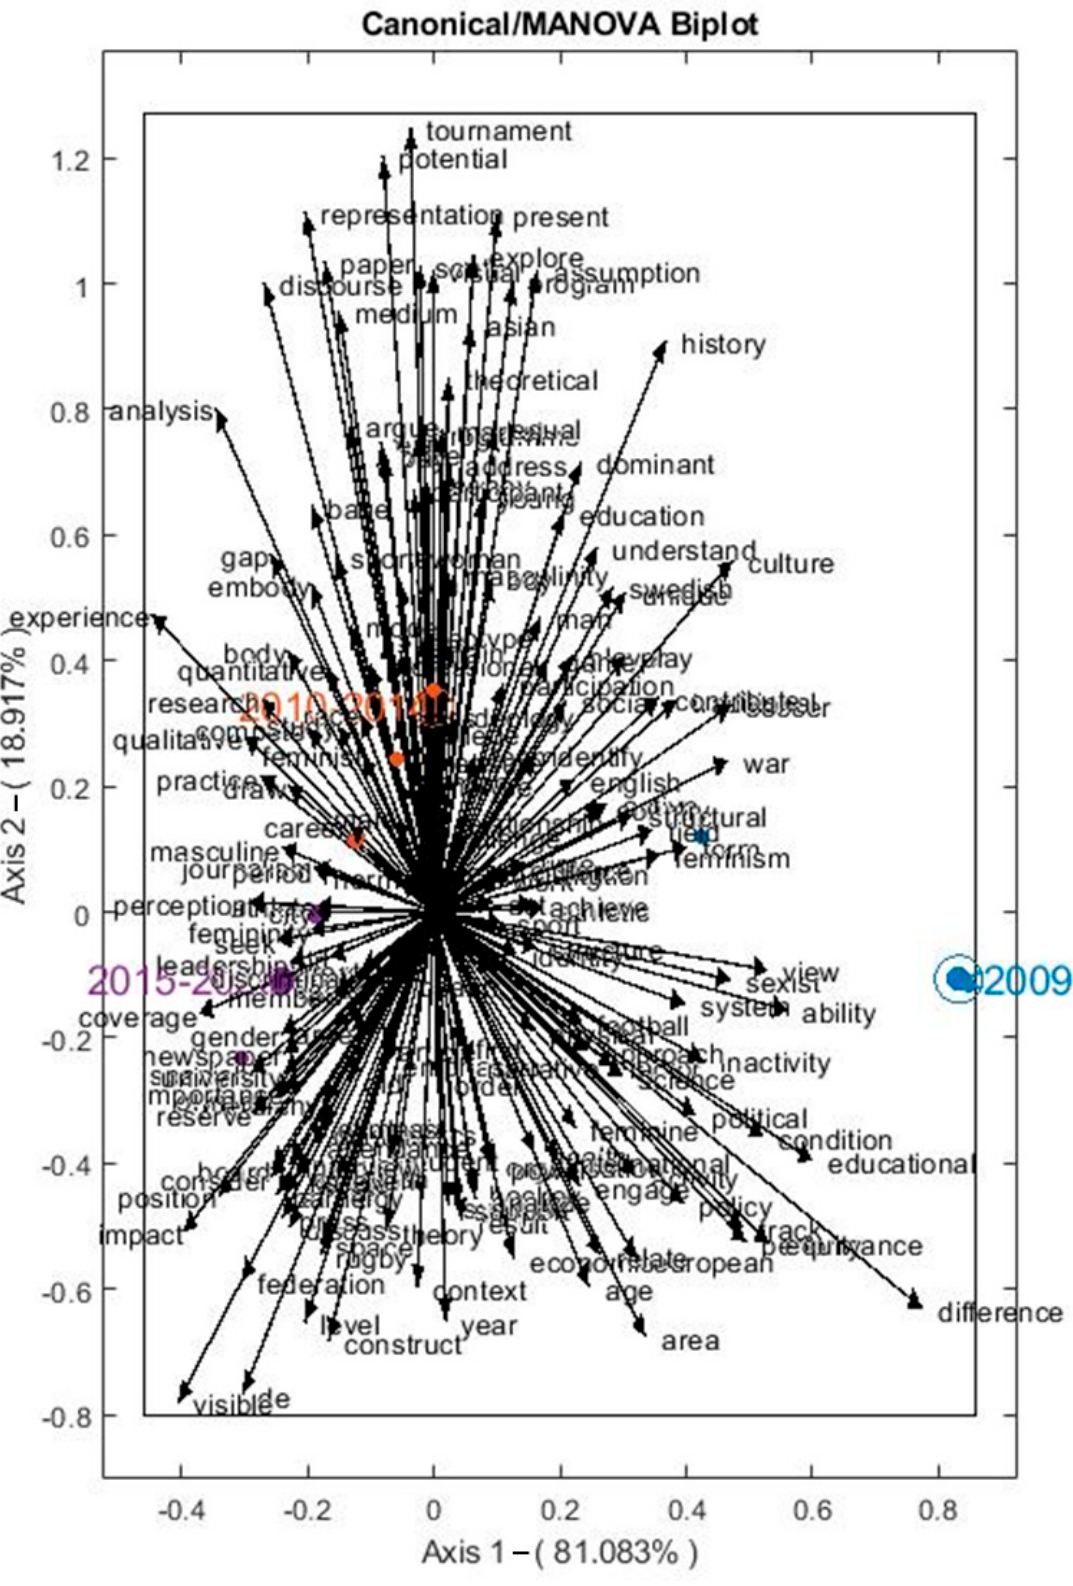
Figure 4. Manova Biplot for SLR inequalities in women’s sport.